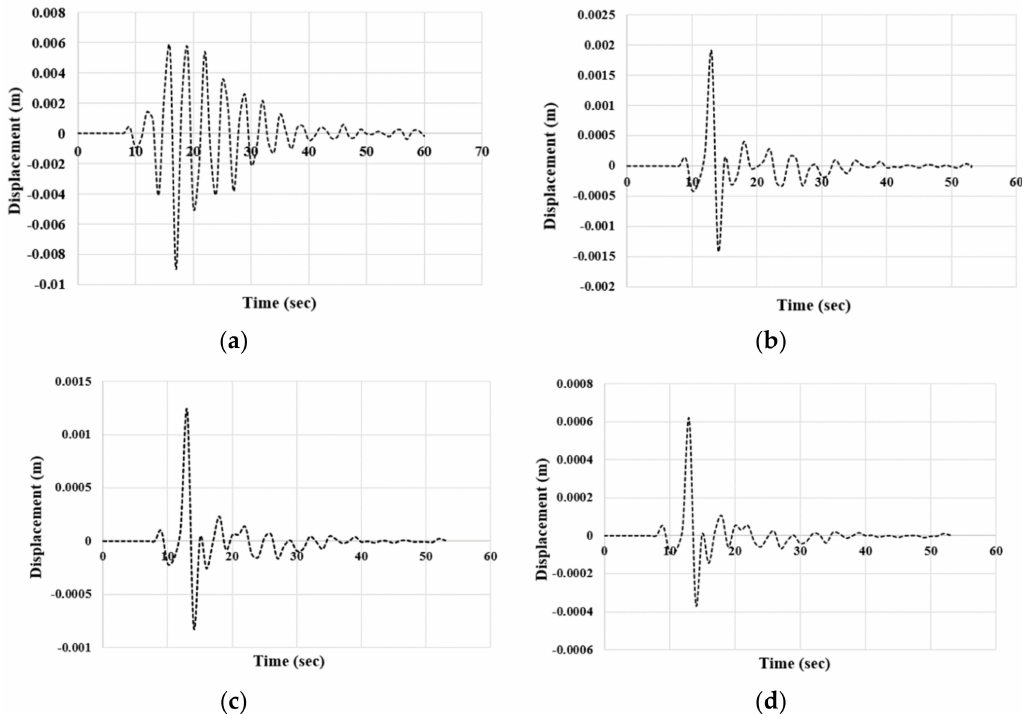
Figure 18. Maximum displacements over time from the Pohang earthquake: ( a ) top of structure; ( b ) taper section; ( c ) concrete cone; and ( d ) concrete sleeve.